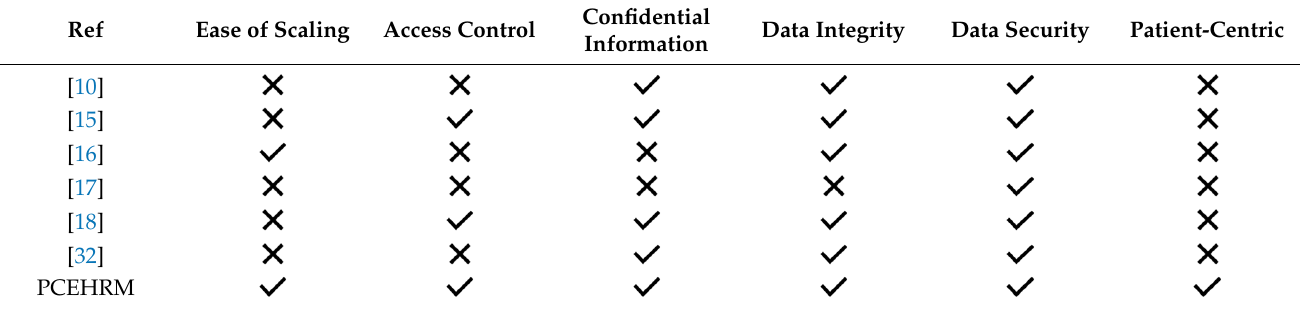
Table 7. Comparison between the existing and suggested patient-centric health storage models.